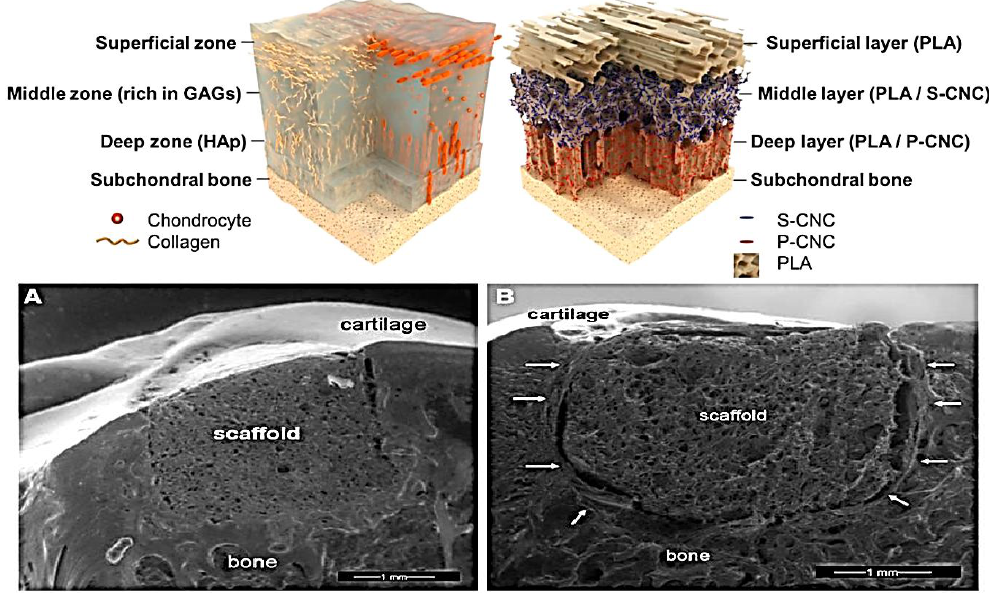
Figure 2. Top . How artificial scaffolds try to mimic the anisotropic characteristic in cartilage tissue [33,34]. Reprinted with permission of [33] Sandra Camarero-Espinosa et al. Biomaterials , 74: 42–52. Bottom . Matrix regeneration within a macroporous non-degradable implant for osteochondral defects is not enhanced with partial enzymatic digestion of the surrounding tissue. ( A ) Environmental scanning electron microscopy of a longitudinal slice taken through the cartilage-bone-implant. The specimen was retrieved at the 1 month post-operative time point. Good integration between the implant and the surrounding bone and articular cartilage was observed. ( B ) Environmental scanning electron microscopy image of a longitudinal slice taken through the cartilage-bone-implant construct at 3 months. Fibrous encapsulation of the implant is highlighted by arrows. Reprinted with permission of [34] Aaron J. Krych et al. J. Mater. Sci. Mater. Med. , 24: 2429–2437.